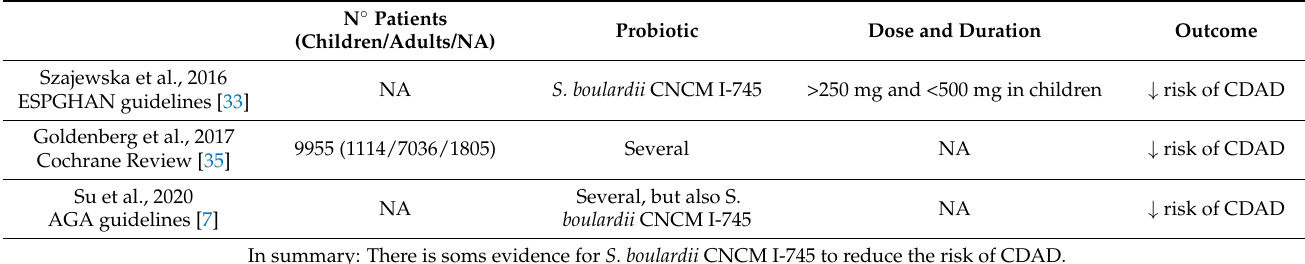
Table 4. Meta-analyses and systematic reviews on probiotics in Clostridioides difficile -associated diarrhea. N ◦ Patients